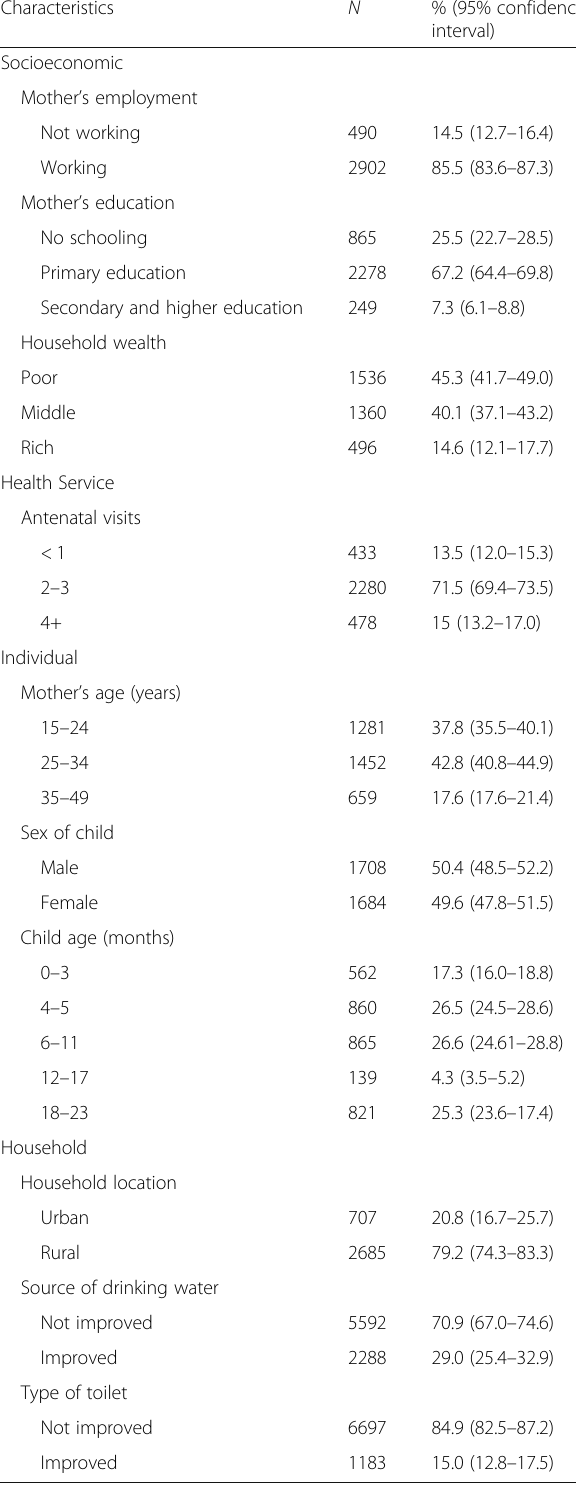
Table 1 Characteristics of the study